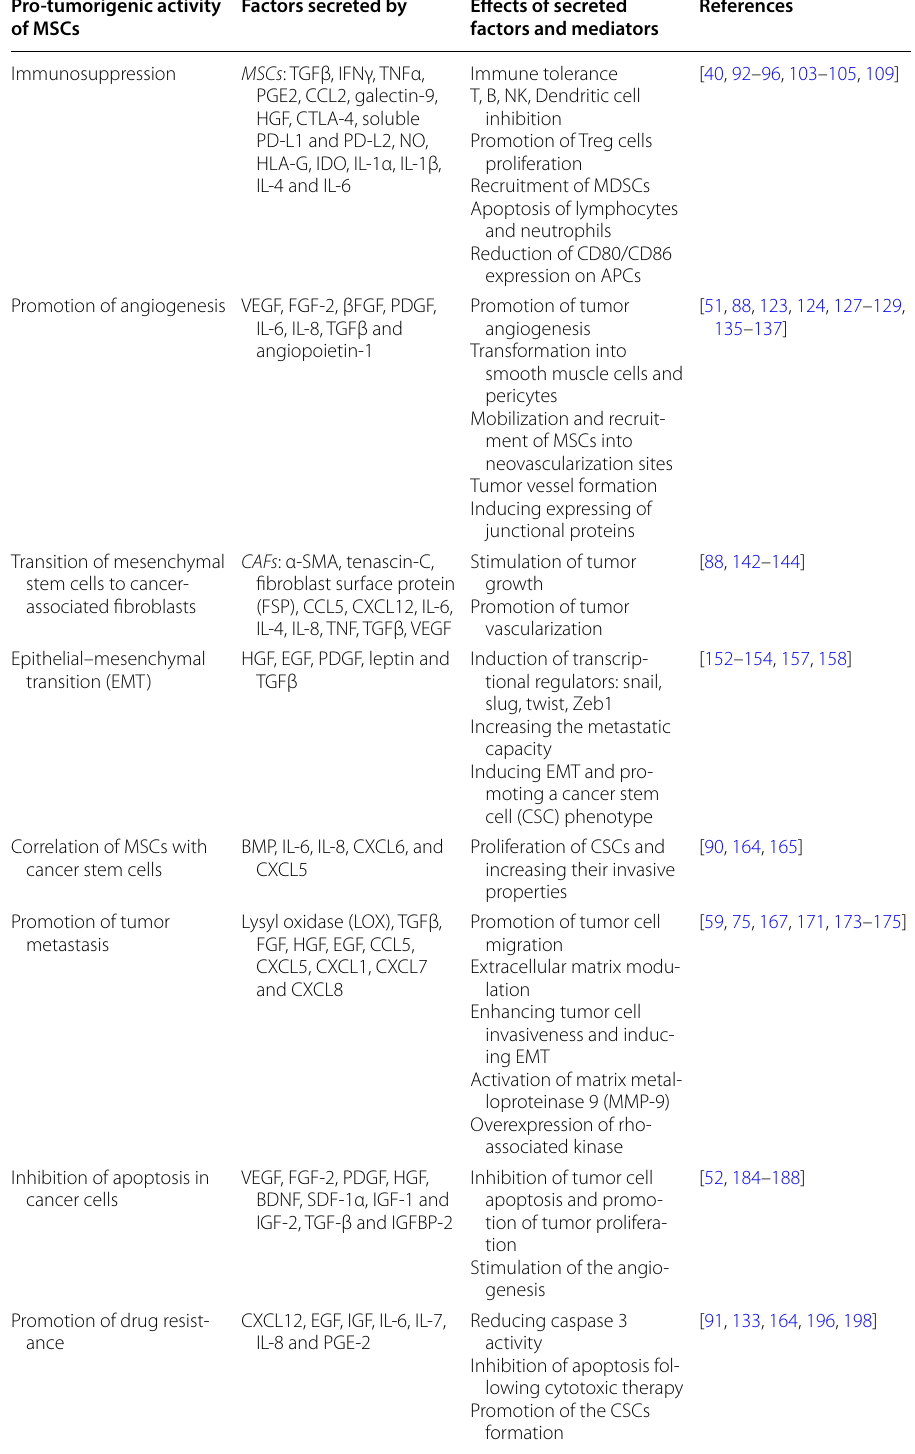
Table 1 The effect of MSC-derived mediators on tumor growth Pro-tumorigenic activity Factors secreted by Effects of secreted of MSCs factors and